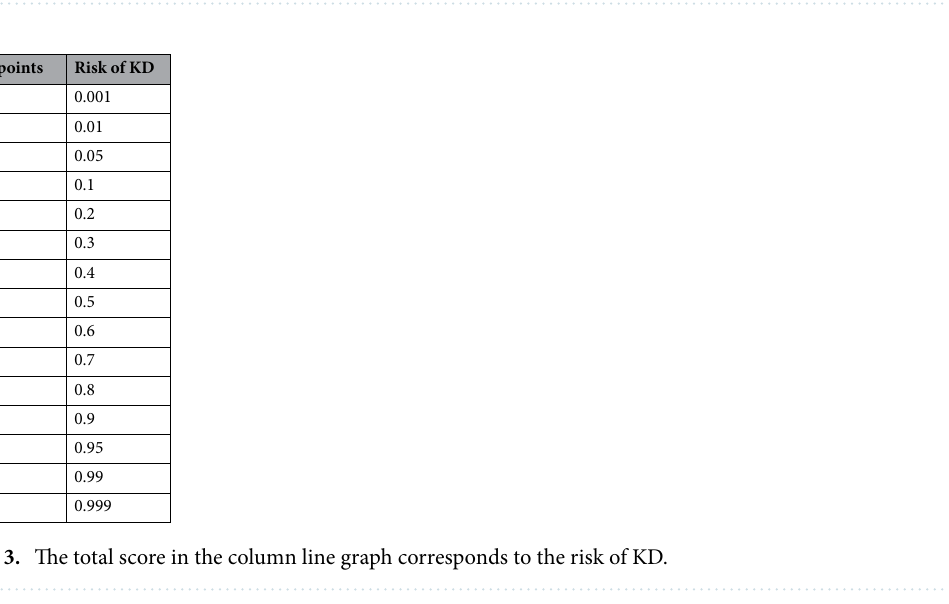
Figure 1. Nomogram plot of KD diagnostic prediction model. WBC (× 10 9 /L); HGB (g/L); CRP(mg/L).